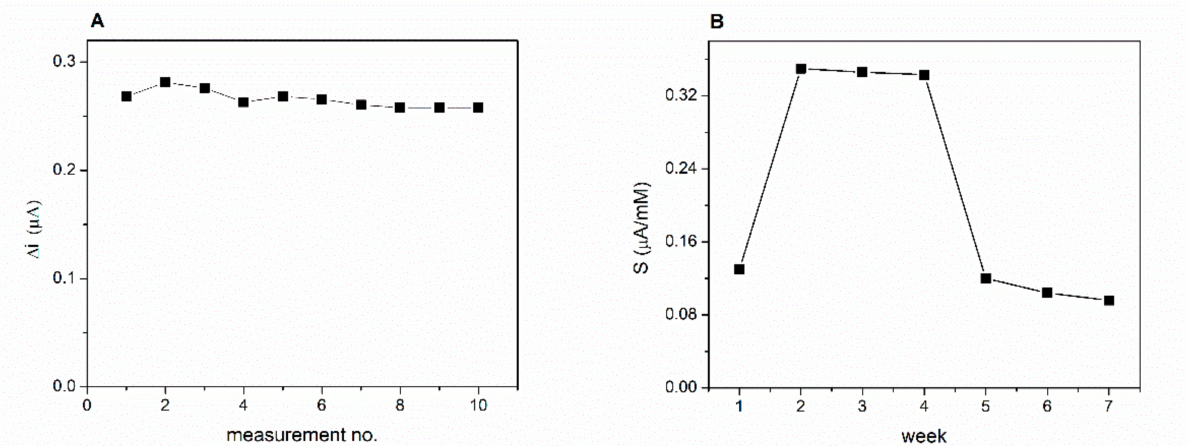
Figure 7. ( A ) Operational stability of the GA-LDH/AuNPs-ERGO-PAH/SPE biosensor. ( B ) Long term stability of the GA-LDH/AuNPs-ERGO-PAH/SPE biosensor (E = +500 mV, [NAD + ] = 8 mM, PBS 0.1 M pH =